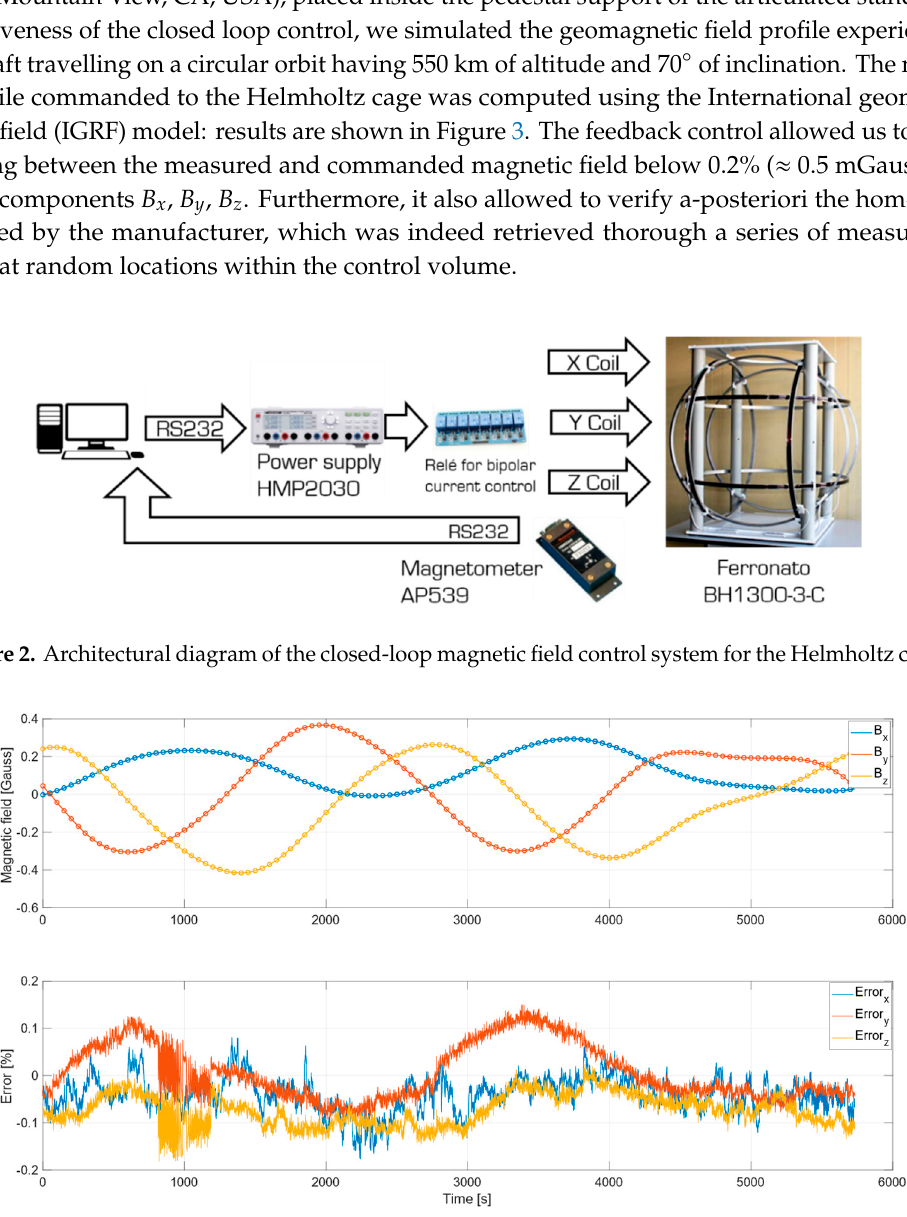
Figure 3. Commanded (full line) versus measured (circled markers) magnetic field components during one orbit simulation (top panel) and corresponding error magnitudes (bottom panel).